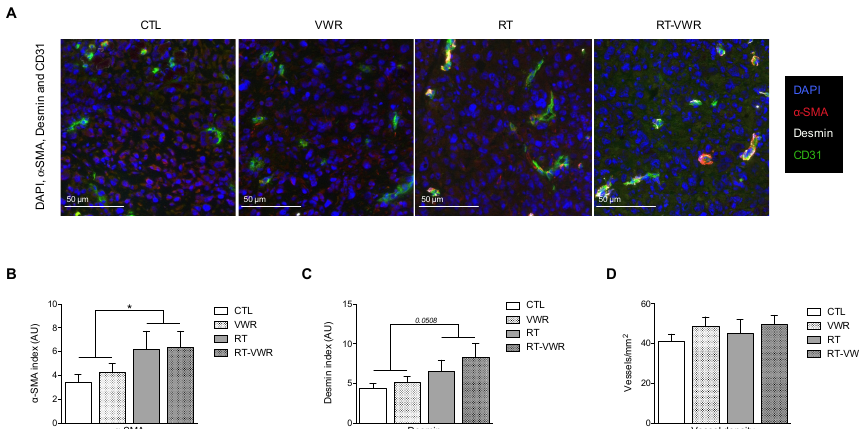
Figure 4. VWR does not provide additional benefits to RT-induced modulation of tumor vasculature. ( A ) Representative images of DAPI (blue), α -SMA (red), desmin (white) and CD31 (green) staining; ( B ) Quantification of α -SMA staining; ( C ) Quantification of desmin staining; ( D ) Quantification of vessel density (vessel/mm 2 ). Data are represented as means ± SEM. * p < 0.05.